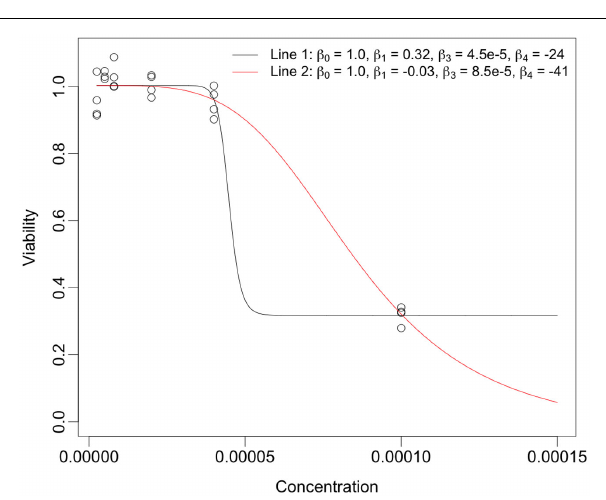
FIGURE 6 | Dramatic example of how very different hill slope curves can give near identical fits for data when drug concentration choices are not well-designed. The legend provides the set of hill slope parameters for each of the lines.